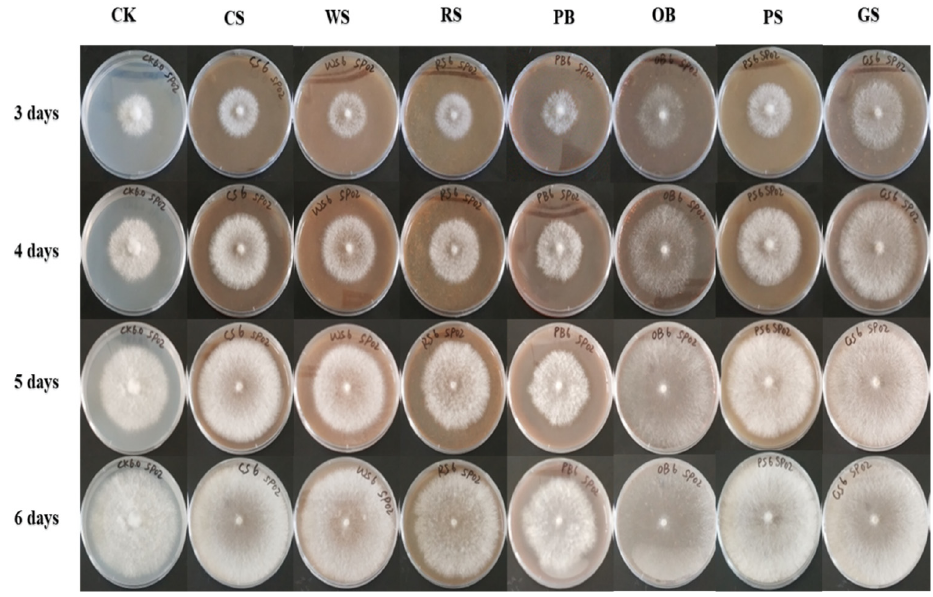
Figure 8. Cultural characteristics of C. unicolor SP02 on plates of different single carbon source.